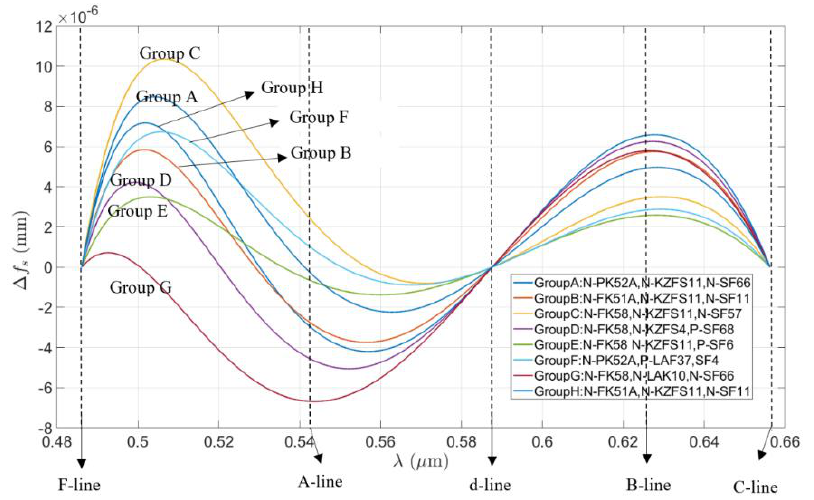
Figure 5. Chromatic aberration curves of the eight triplet lens combinations selected by the illustra- tion method.